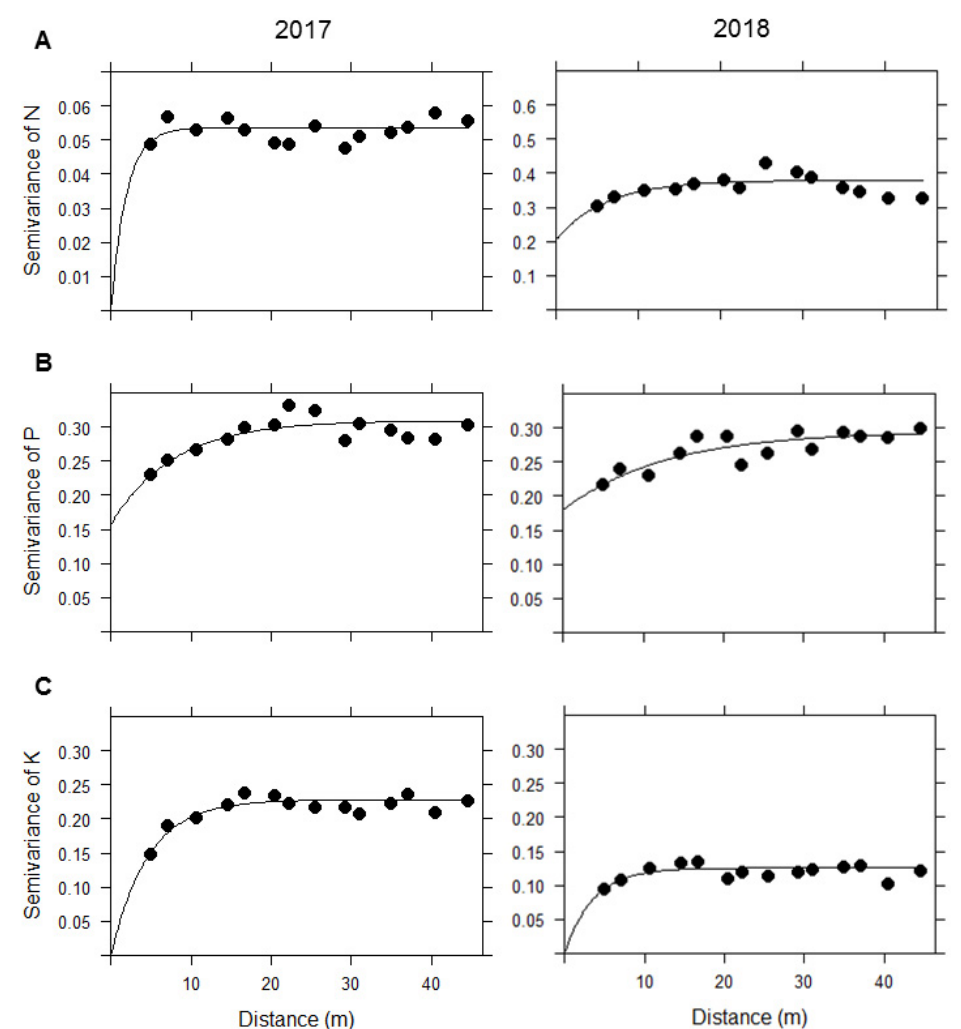
Figure 4. Semivariograms of the fitted models for ( a ) N, ( b ) P, and ( c ) K in 2017 and 2018. The black dots indicate the semivariance values of the data as a function of distance, while the solid line represents the fitted exponential model associated with each nutrient. Table 2. Plant species richness, mean plant abundance per hectare, and mean Shannon–Wiener index (H’) for vegetation evaluated after the fire. Different letters represent statistically significant differences (at α = 0.05) between the period of evaluation within each year. Significant differences compared to the unburned forest (UBF) are represented by *** for p < 0.001, ** for p < 0.01, and *